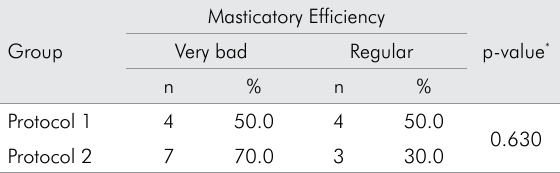
Table 6. Masticatory Efficiency (ME) classification in both ERAS group (Protocol 1) and control group (Protocol 2) in the 60 th post-operative day.